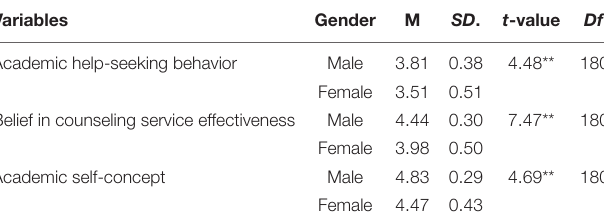
TABLE 1 | Gender difference in study